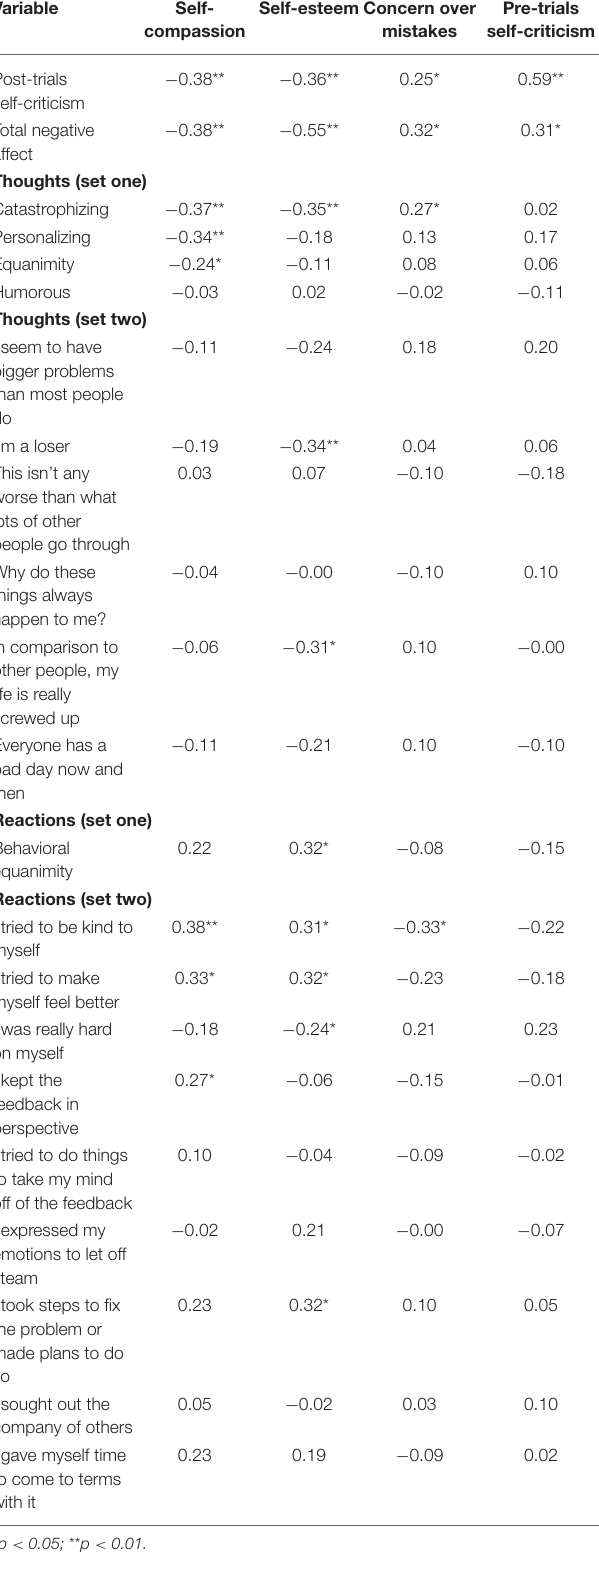
TABLE 4 | One-tailed Pearson correlations of psychological scales and subscales for Phase II participants. Variable